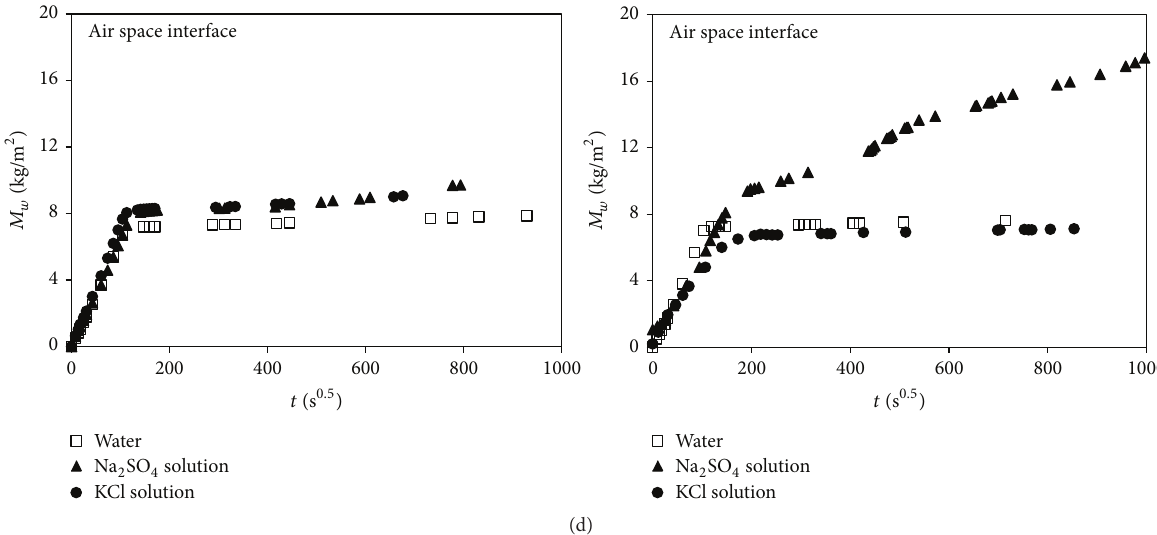
Figure 4: Capillary absorption curve of red brick samples as a function of the root of time, after 1 and 2 cycles, with pure water and saturated solutions of KCl and Na 2 SO 4 , for (a) monolithic specimens, (b) hydraulic continuity interface, (c) perfect contact interface, and (d) air space